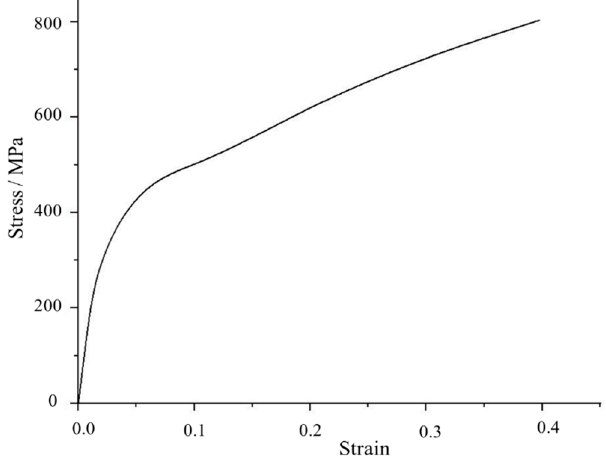
Figure 5. Stress–strain curve of 06cr19ni10 material.